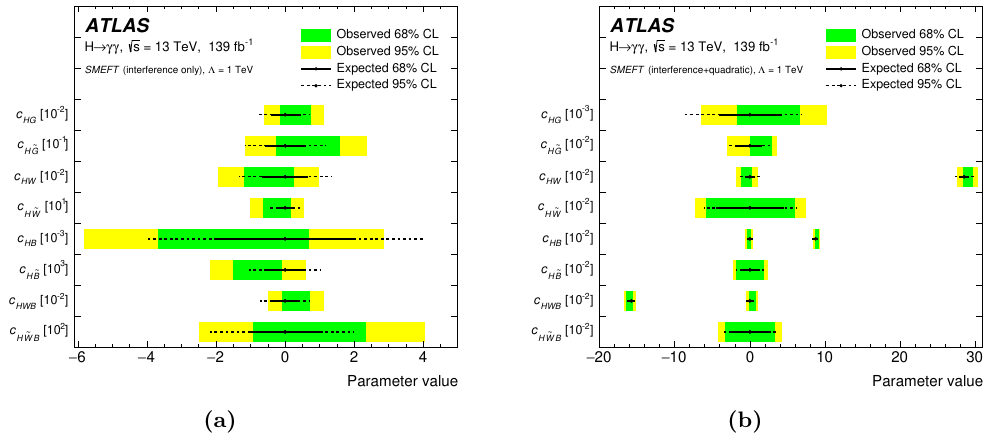
Figure 21. Observed and expected 68% and 95% CL limits on SMEFT Wilson coefficients using (a) SM and dimension-6 operators interference-only terms and (b) including quadratic dimension-6 terms. Limits are derived by fitting one Wilson coefficient at a time while setting the other coefficients to zero. The limits are computed at a new-physics scale Λ = 1 TeV